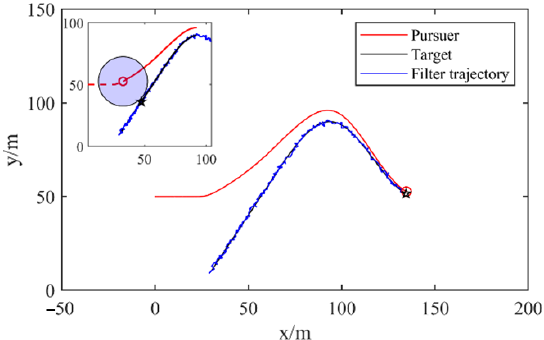
Figure 3. The trajectories of pursuer and evader.